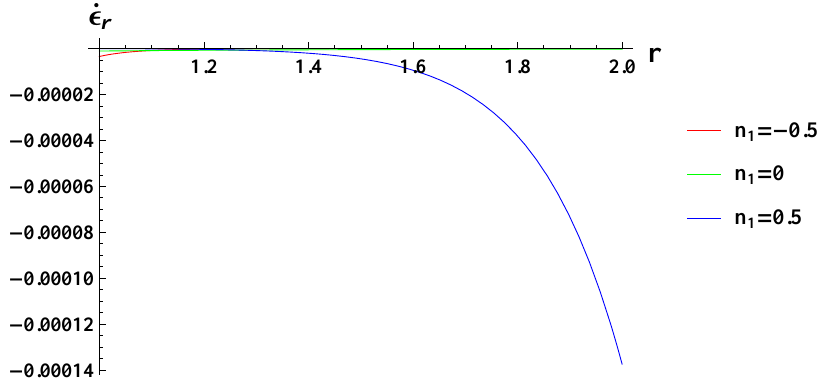
Figure 4. Tangential stress (in MPa) along the radius r (in cm) of the cylinder, under the effect of rotation ( ω 2 = 50 rad/s), internal pressure p i = 50 MPa and exponential volume reinforcement. As observed in Figure 5, radial strain rate under internal pressure is compressive in nature. The radial strain rate is highly compressive in cylinder with reinforcement n 1 = 0.5 but decreases in magnitude for n 1 = 0.5 and n 1 = 0.